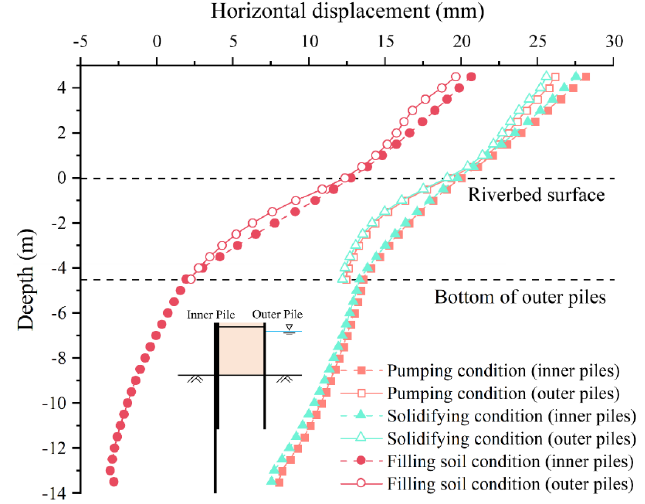
Figure 25. Horizontal displacement of reinforced piles.